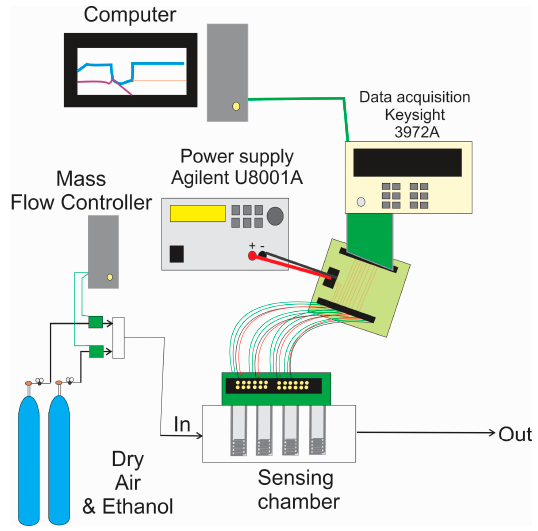
Figure 1. Scheme of the experimental set-up employed to study the response of the sensors towards different ethanol concentrations.